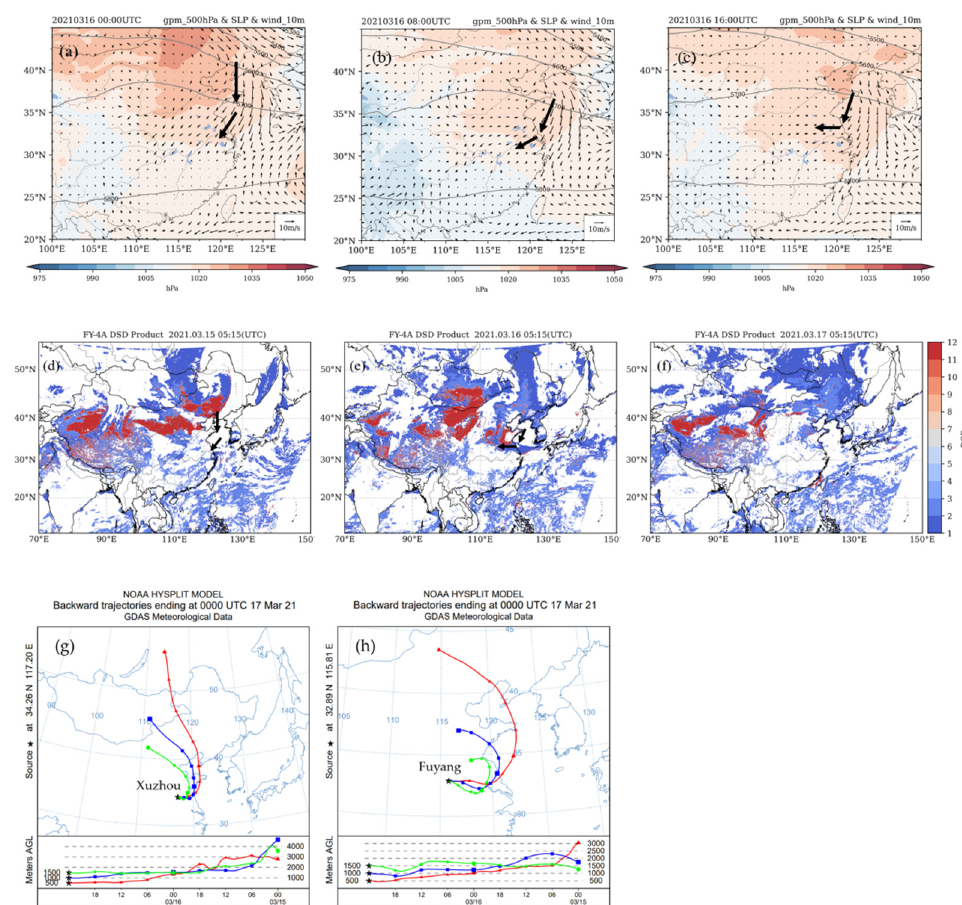
Figure 9. Dust backflow process analysis on 16 and 17 March 2021. ( a – c ) The sea level pressure (shading) overlapped by 10-m wind vectors (arrow) and 500 hPa geopotential height contours (gray line) at ( a ) 00:00 on 16 March 2021; ( b ) 08:00 on 16 March 2021; ( c ) 16:00 UTC on 16 March 2021; ( d – f ) Dust test product from FY-4A (red dash); ( d ) 05:15 UTC on 15 March 2021; ( e ) 05:15 on 16 March 2021; ( f ) 13:15 UTC on 17 March 2021; ( g ) 48 h backward trajectories ending at Fuyang; ( h ) and Xuzhou on 16 March.